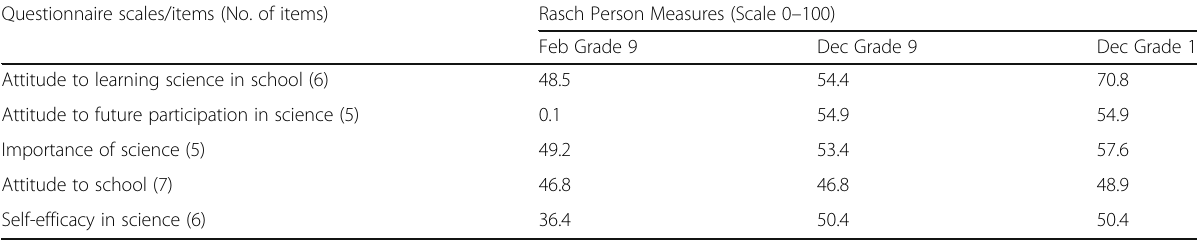
Table 2 Rachel ’ s Rasch person measures for attitudes and self-efficacy questionnaire scales Questionnaire scales/items (No. of items)